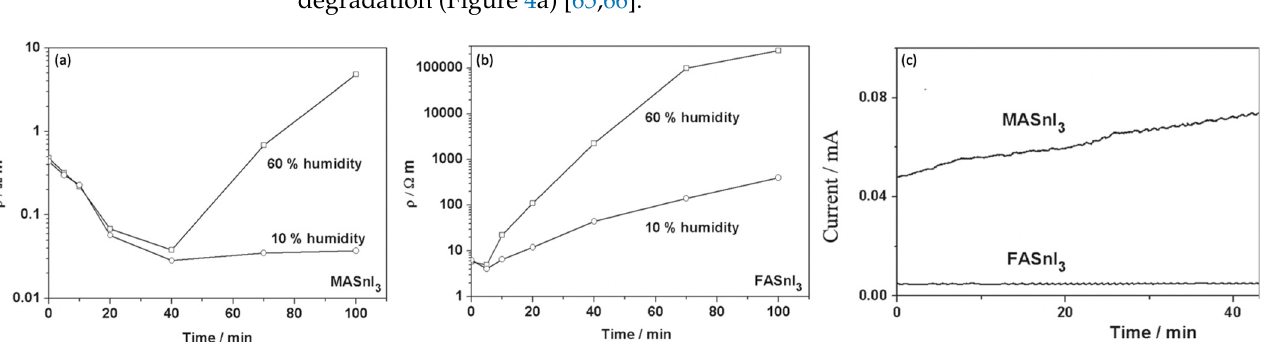
Figure 3. As a function of time and humidity, the resistivity of ( a ) MASnI 3 and ( b ) FASnI 3 . ( c ) In a glovebox in the dark, the MASnI 3 and FASnI 3 conductor structures were characterized by the current they carry when biased by 1 V. Reproduced with permission [63]. Copyright 2016, WILEY-VCH.